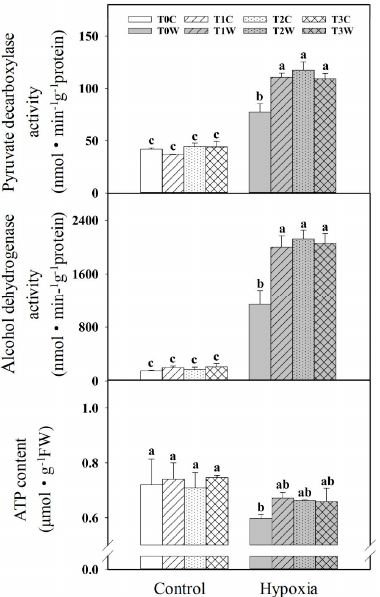
Plants 2022 , 11 , x FOR PEER REVIEW